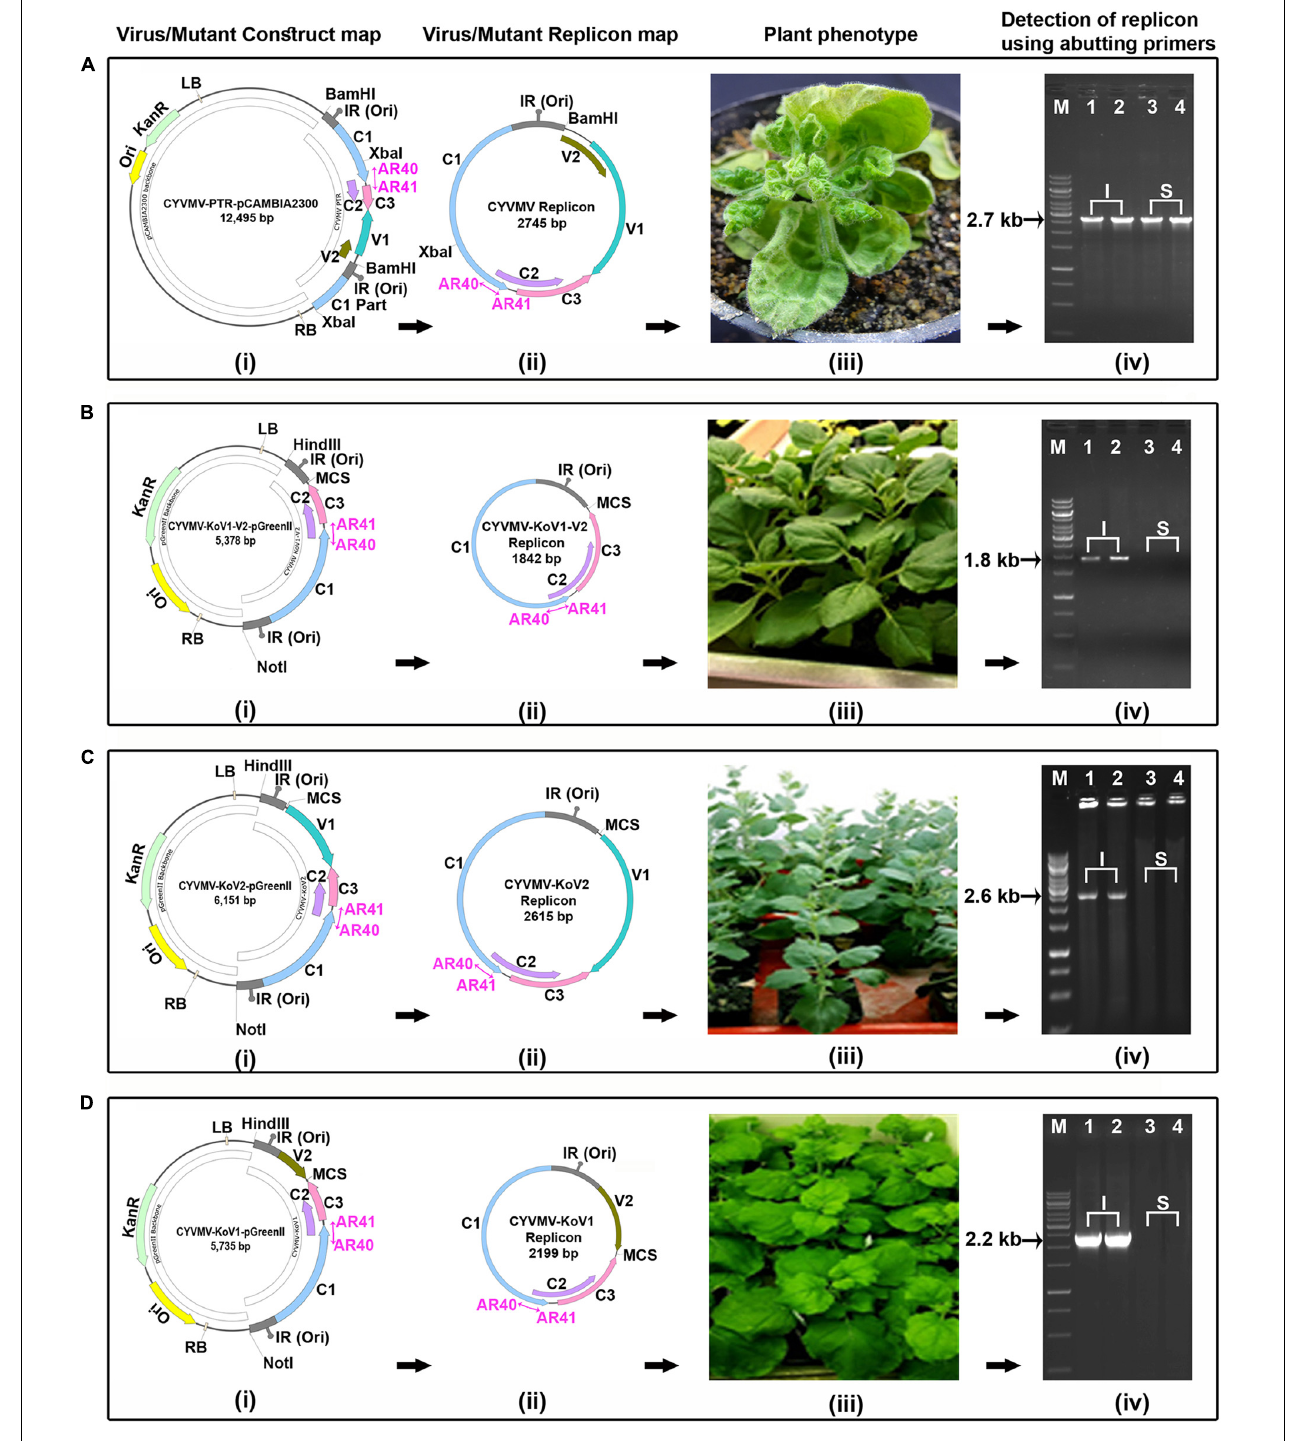
FIGURE 8 | Both CYVMV V1 and V2 are required for CYVMV movement. Infiltrations of CYVMV infectious clone (CYVMV-PTR-pCAMBIA2300) (A) and deletion constructs of V1/V2 double (CYVMV-KoV1-V2-pGreenII) (B) , V2 single (CYVMV-KoV2-pGreenII) (C) and V1 single (CYVMV-KoV1-pGreenII) (D) to N. benthamiana leaves for the infectivity assay. Construct maps (i), viral/deletion episomal replicons released from vector backbone inside the plant (ii), symptom phenotype (iii), and detection of viral/mutant replicons using abutting primers (AR40, AR41) in infiltrated (I) and systemic (S) leaves (iv). All three deletion constructs did not cause any symptoms and were detected only in infiltrated leaves. In contrast, inoculation of the wild-type CYVMV led to infection symptoms, and the virus was present in both infiltrated and systemically infected leaves. Locations of the abutting primers AR40 and AR41 were marked as violate color arrows in the constructs and replicons.